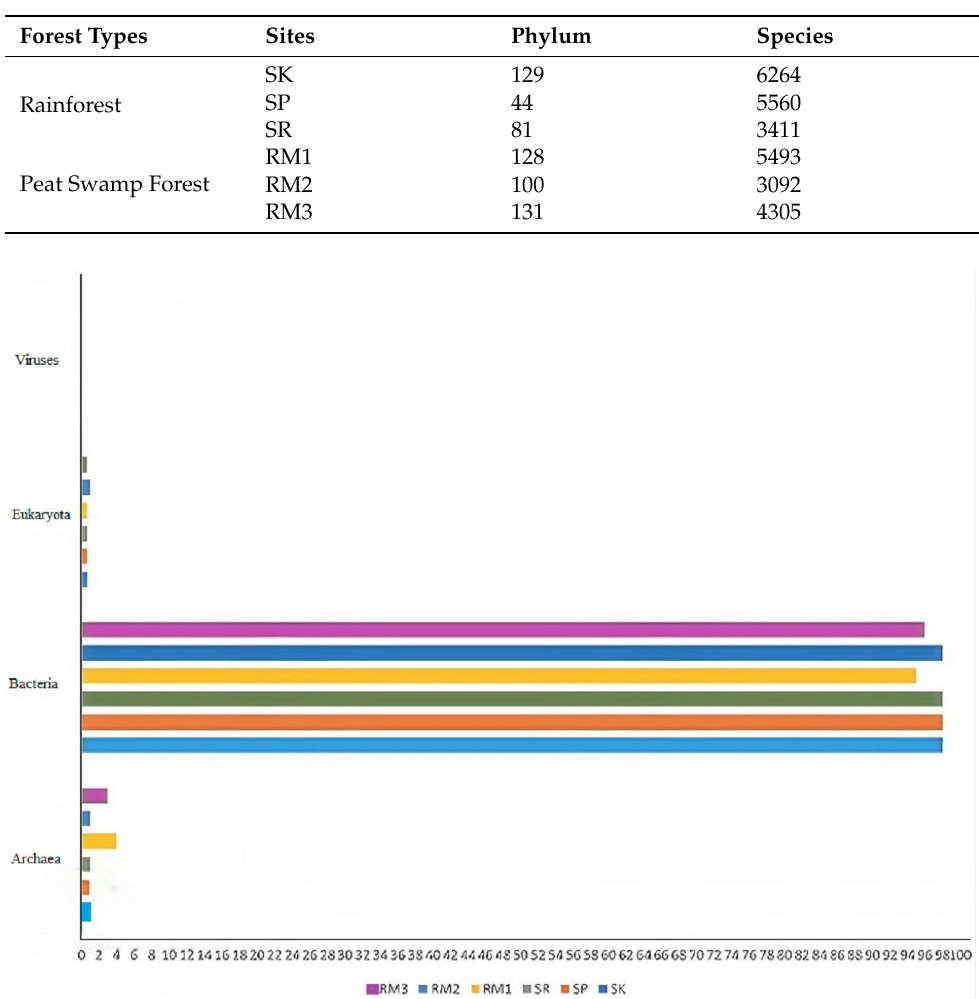
Table 1. Blast hits against the nonredundant protein sequences database of NCBI (NCBI-nr).